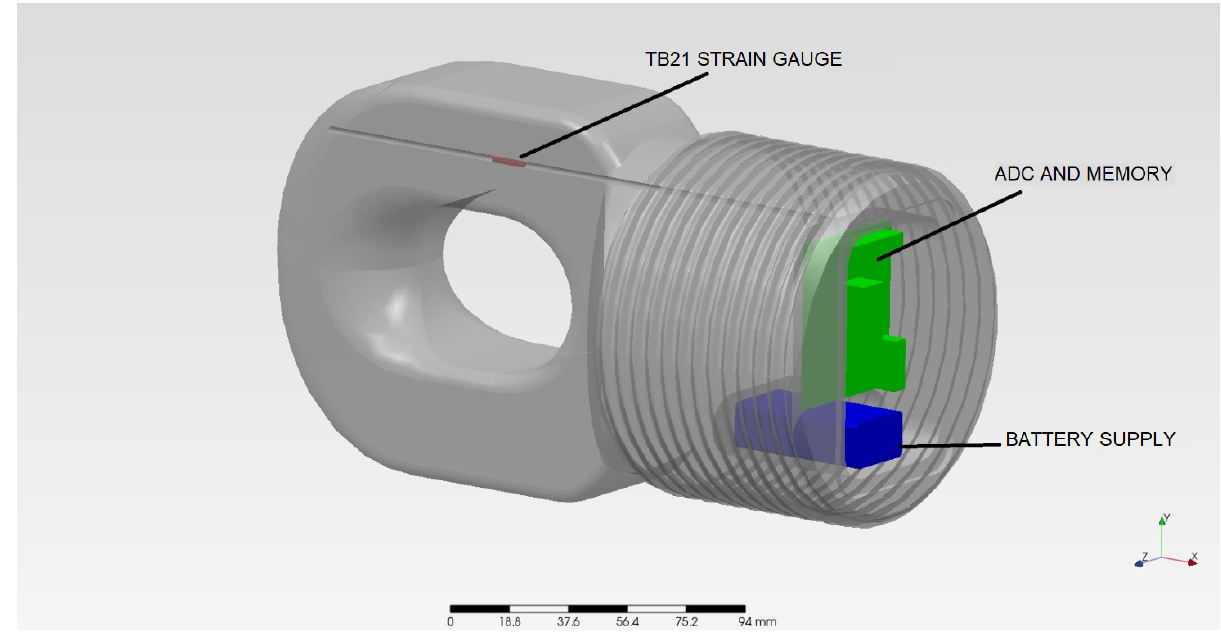
Figure 7. Location of transducer components inside the chain swivel.